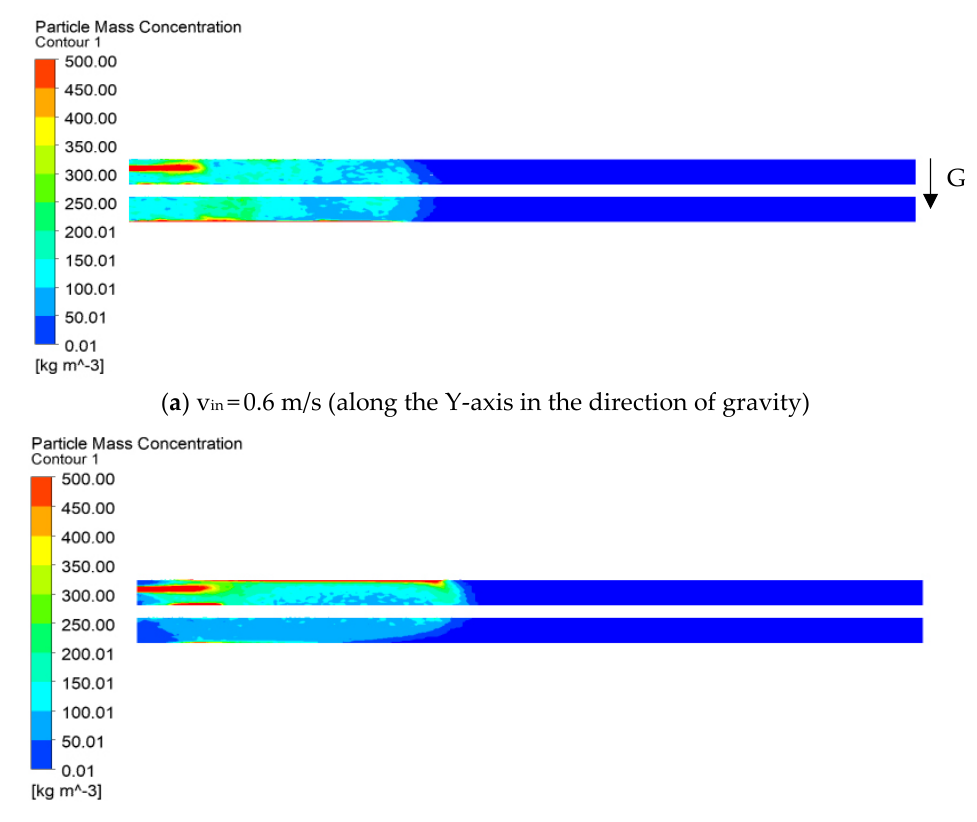
Figure 10. Particle concentration contours.